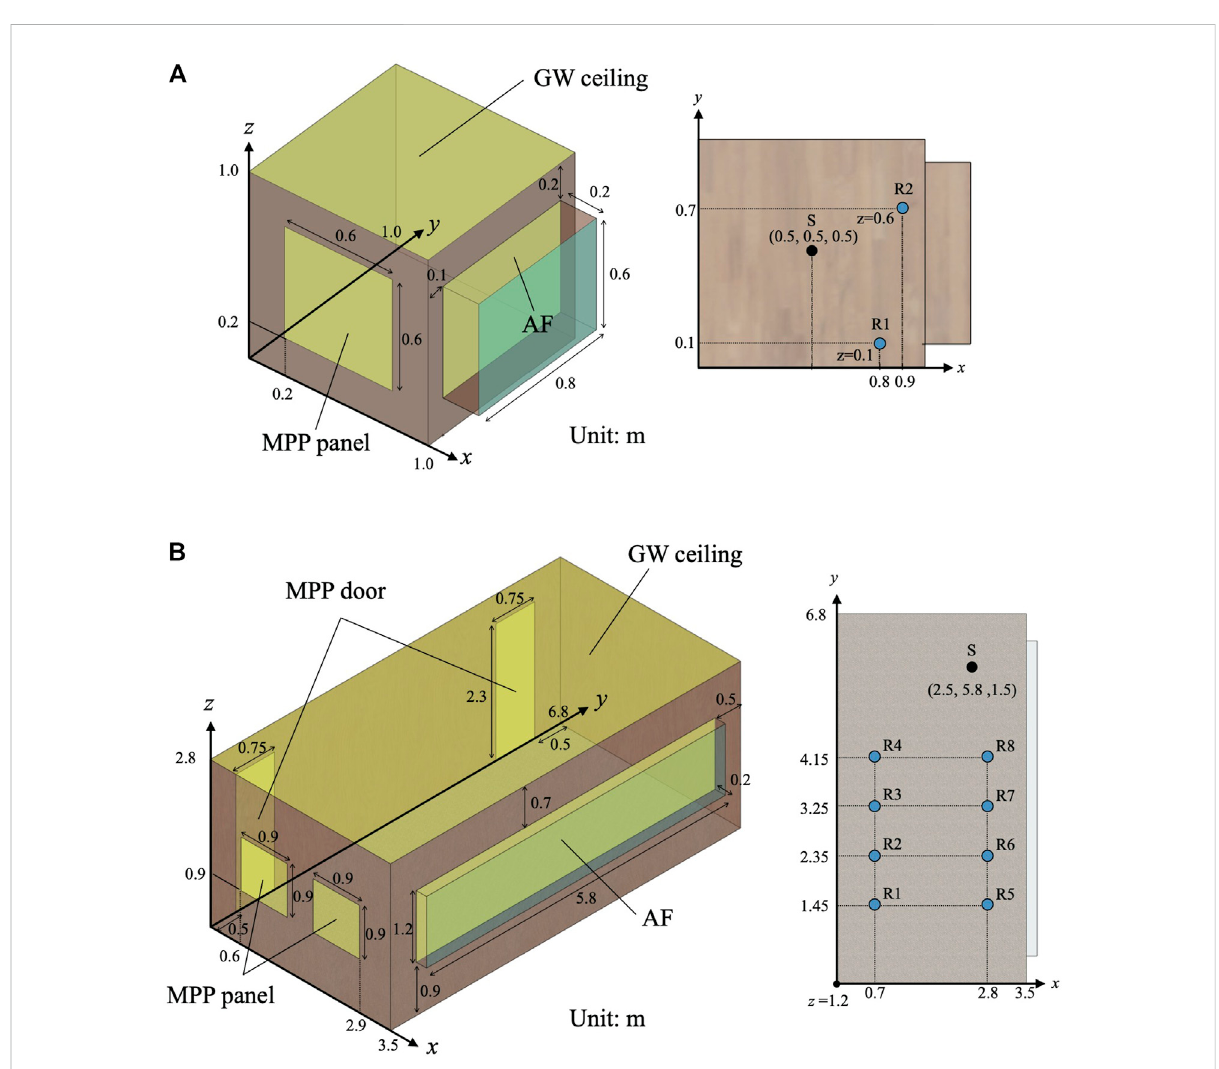
FIGURE 1 Room models: (A) Small room of 1.01 m 3 with asource S andtwo receivers R1 and R2;and (B) Meetingroom of 68 m 3 with asource Sand eight receivers R1 – R8. Both rooms include GW absorber on ceiling, MPP absorber on walls, and AF absorber in front of a window. The Meeting room further includes MPP absorbers as